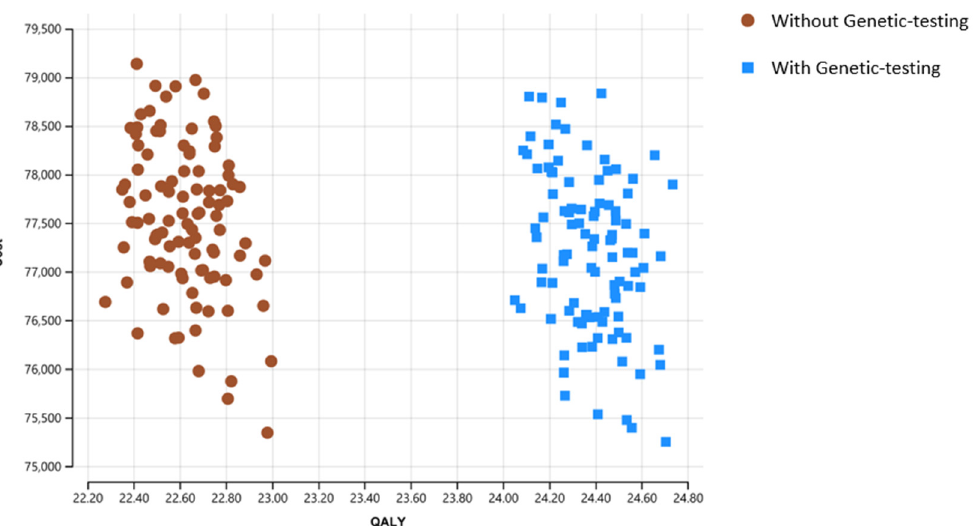
Figure 3. Cost-effectiveness probabilistic sensitivity analysis of GT over wGT demonstrating cost and effectiveness of the models’ strategies over 10,000 iterations with simultaneous variation of input values. In the scatterplot each dot represents a single simulated cohort within the possible range of the variable’s values. The X axis represented QALYs gained, and Y axis represent the overall costs. In all iterations GT resulted higher QALY, mostly in higher cost. GT: genetic testing; QALY: quality-adjusted life years.